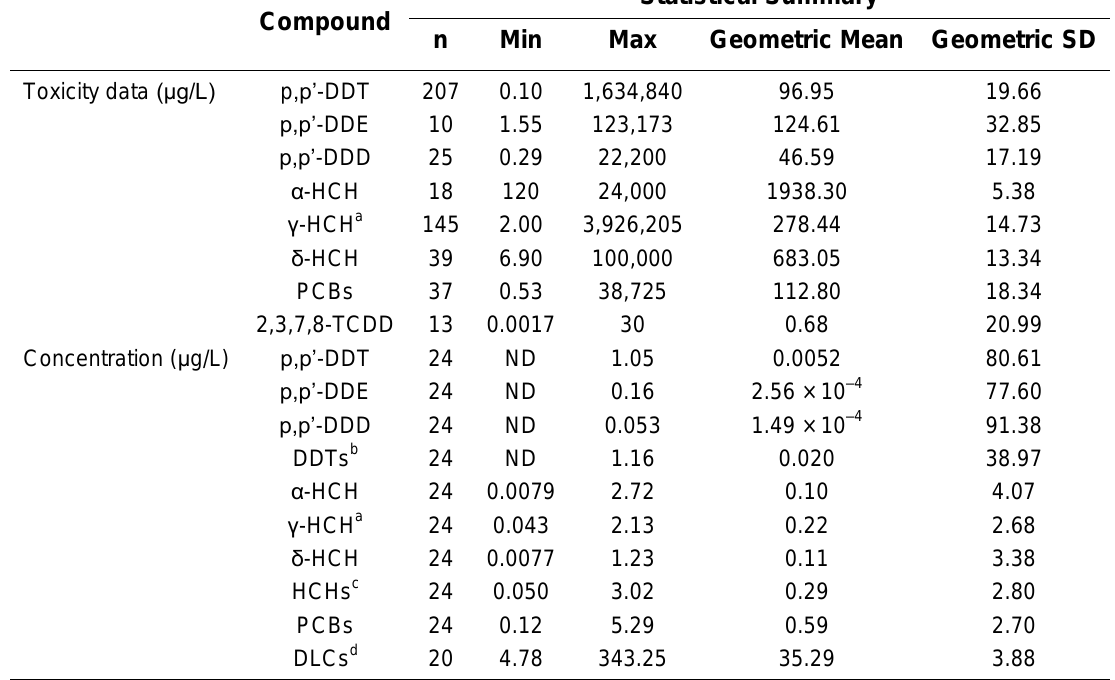
Statistical Summary of Species Toxicity Data of the Studied POPs and Their Concentrations in the Haihe River Statistical